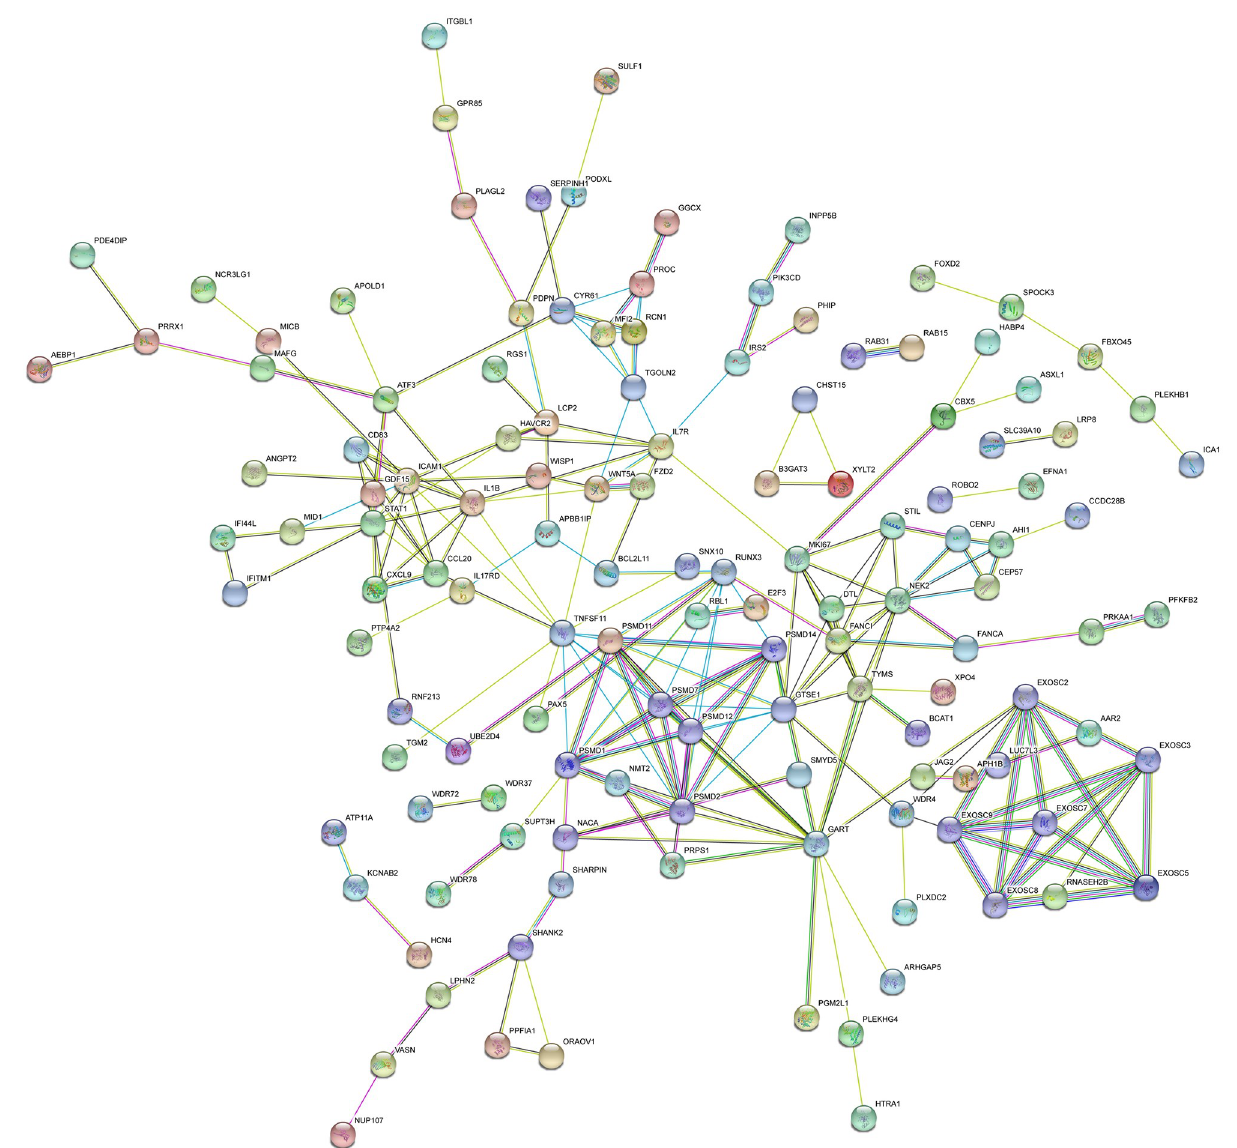
Fig 3. PPI networks of significantly upregulated DEGs. Colored nodes: query proteins and first shell of interactors; white nodes: second shell of interactors; Blue-green line: known interactions from curated databases; purple line: known interactions from experimentally determined; green line: predicted interactions from gene neighborhood; red line: predicted interactions from gene fusions; dark blue: predicted interac- tions from gene co-occurrence; yellow line: interactions from textmining; black line: interac- tions from co-expression; light blue: interactions from protein homology.